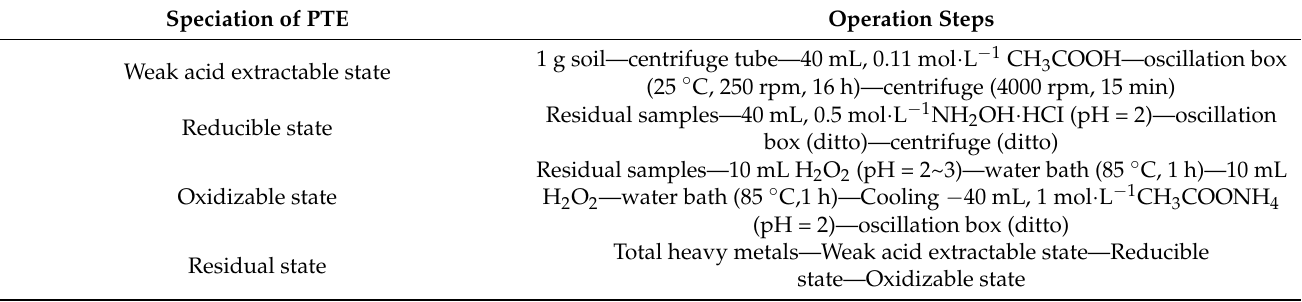
Table 2. Operation steps of fractionation of